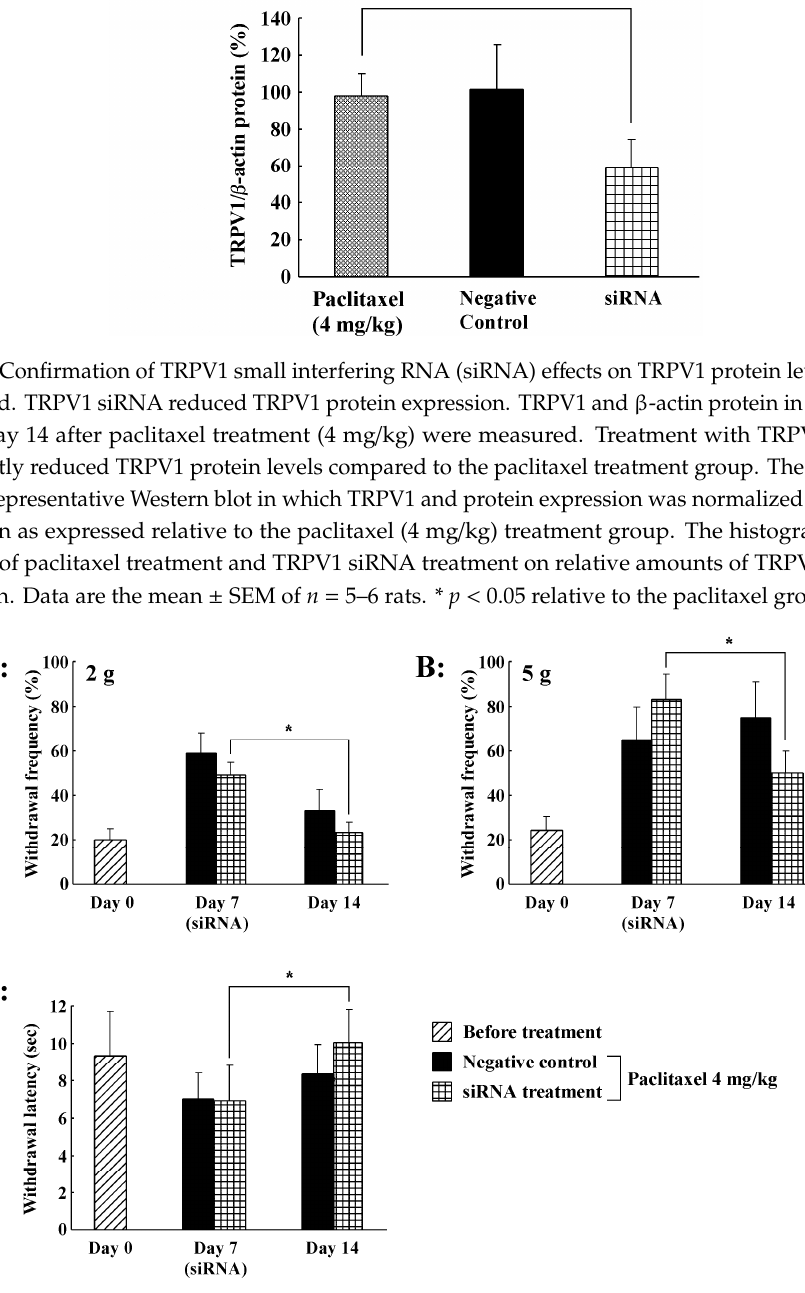
Figure 6. Effect of intrathecal administration of TRPV1 siRNA on paclitaxel-induced peripheral neuropathy. The TRPV1 siRNA or siRNA-negative control was intrathecally administered on days 11 to 14 after the start of paclitaxel treatment. ( A ) Paclitaxel-induced mechanical allodynia and ( B ) Paclitaxel-induced hyperalgesia, and ( C ) Paclitaxel-induced thermal hyperalgesia were significantly reduced in the TRPV1 siRNA group at day 14 relative to the siRNA-negative control group. Histograms show withdrawal responses at days 0, 7, and 14 after the start of paclitaxel treatment. Data are the mean ± SEM of n = 5–6 rats. * p < 0.05 in statistical comparison between days 7 and 14.